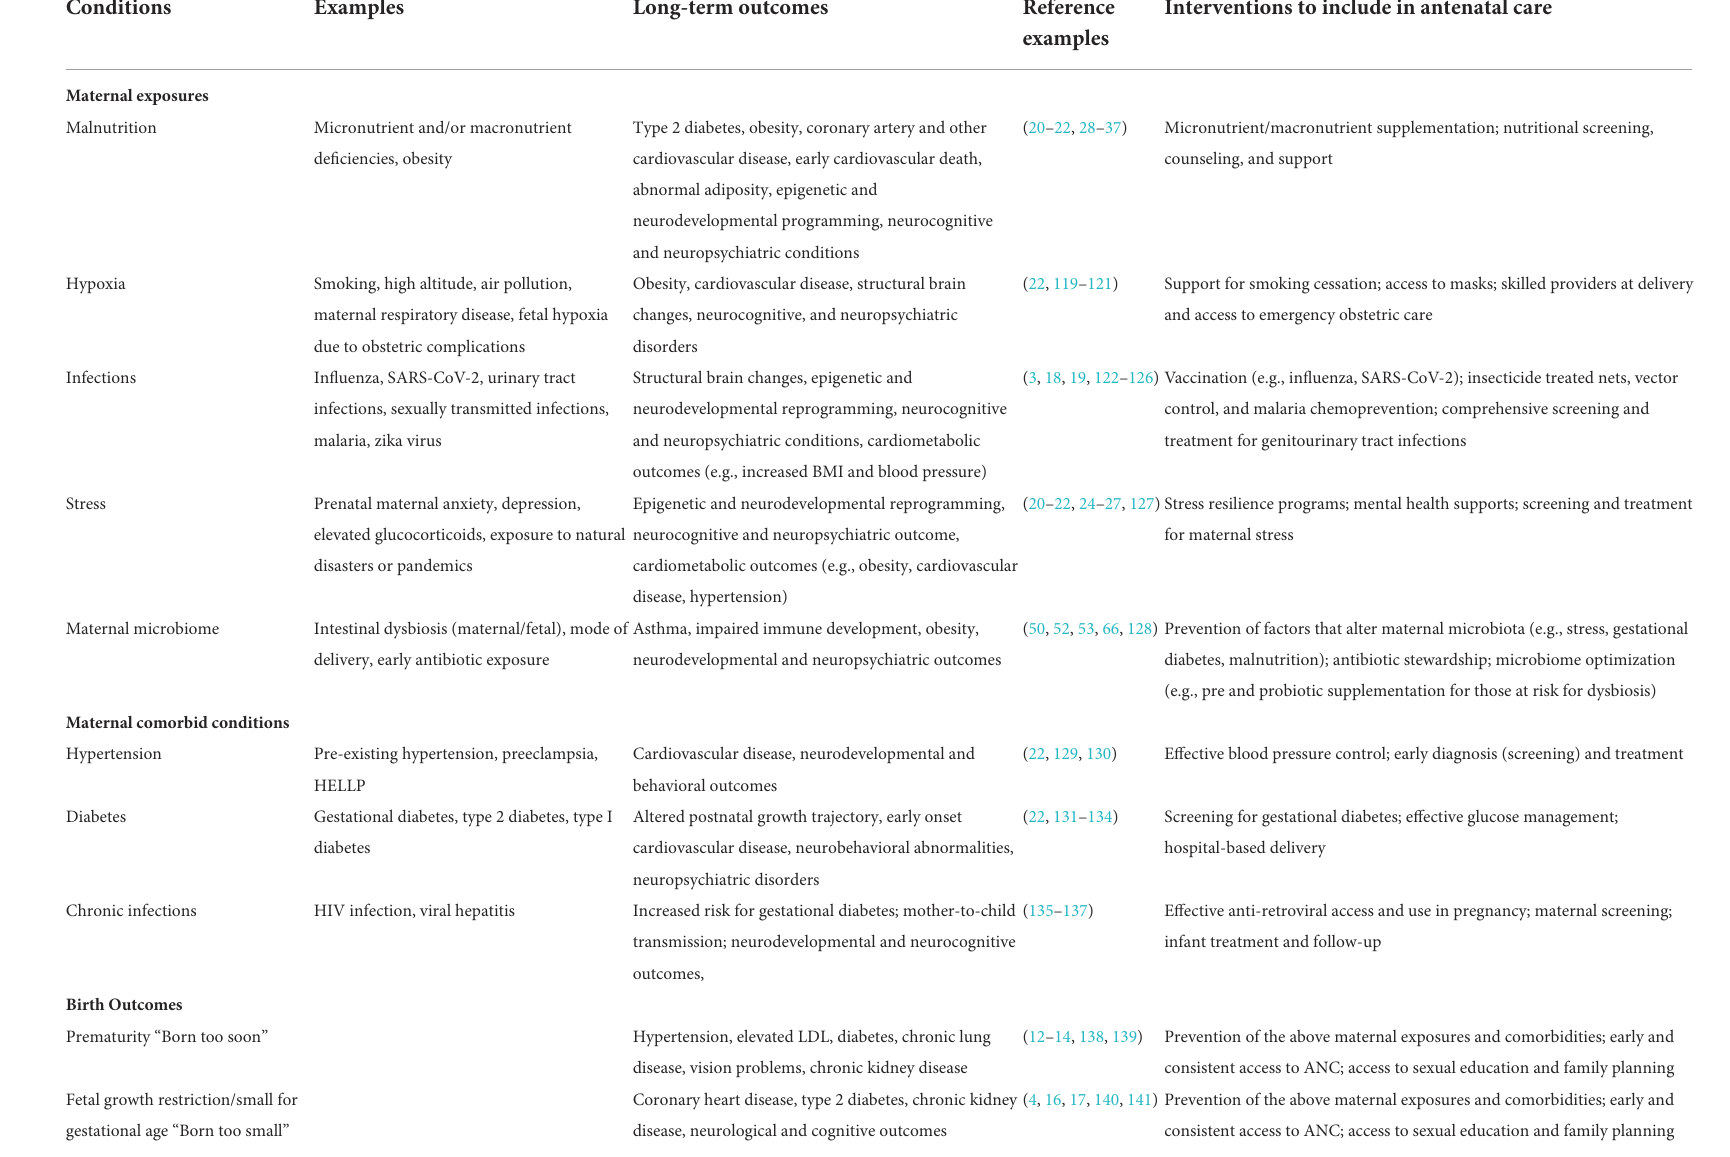
TABLE 1 Maternal exposures during pregnancy that may impact long-term health outcomes and potential